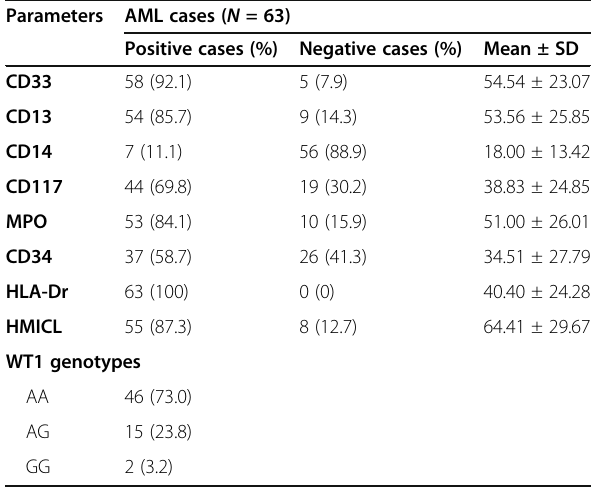
Table 2 Frequency of immunophenotyping, hMICL, and